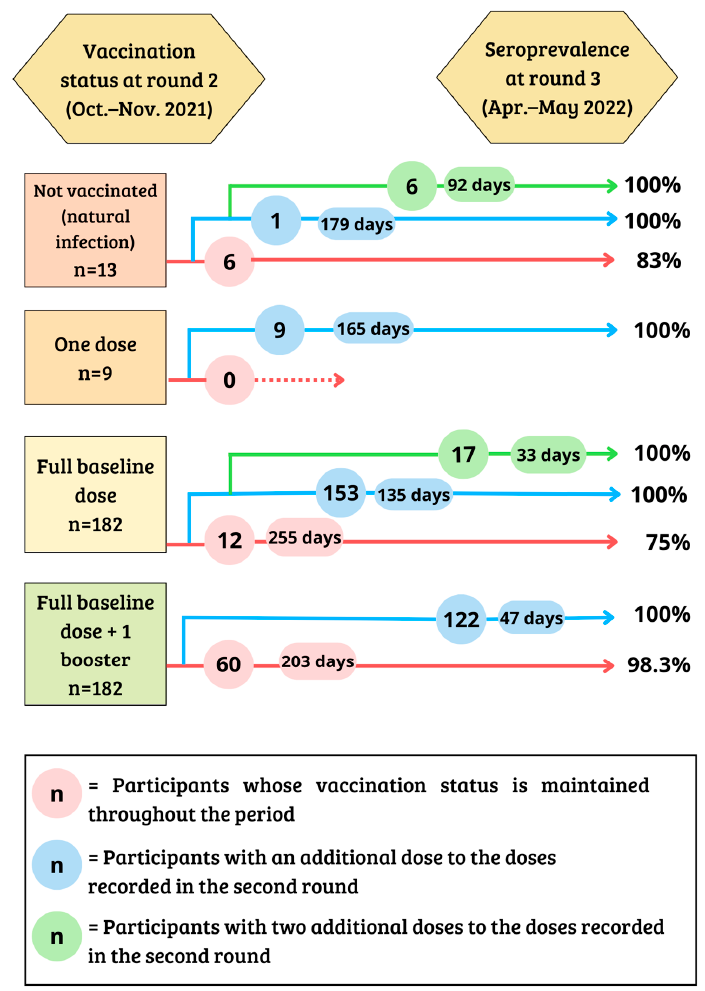
Figure 3. Seroprevalence rates in participants who did not receive another vaccine during the period and participants who received one (or two) additional doses during the period between rounds 2 and 3, respectively, according to second-round vaccination status and mean number of days since the last dose.